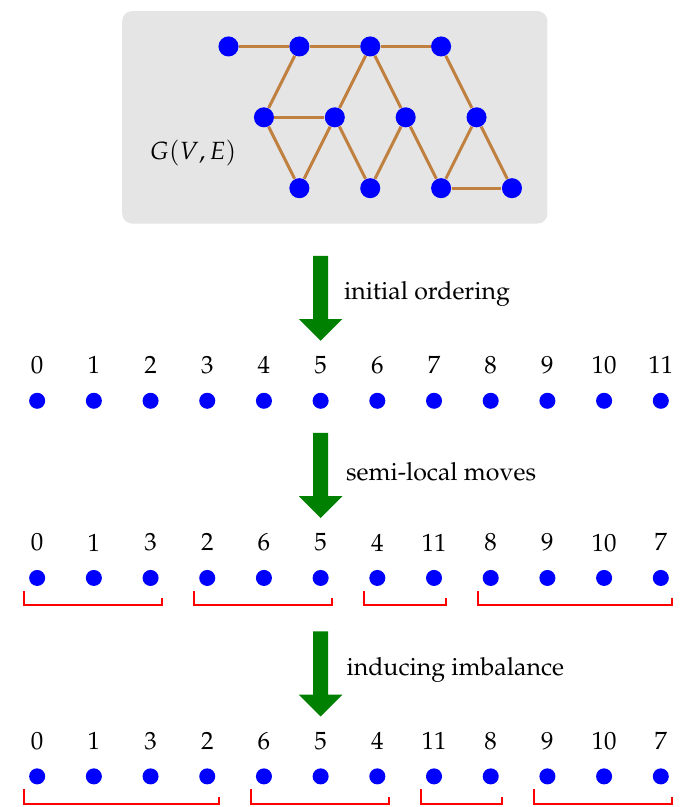
Figure 1. A natural flow for our algorithm (Algorithm 1). The vertices of G are first embedded on a line, then the embedding is improved via swaps and finally imbalanced clusters are created according to the ordering of vertices. As we explain later on, iterating on these steps yields better